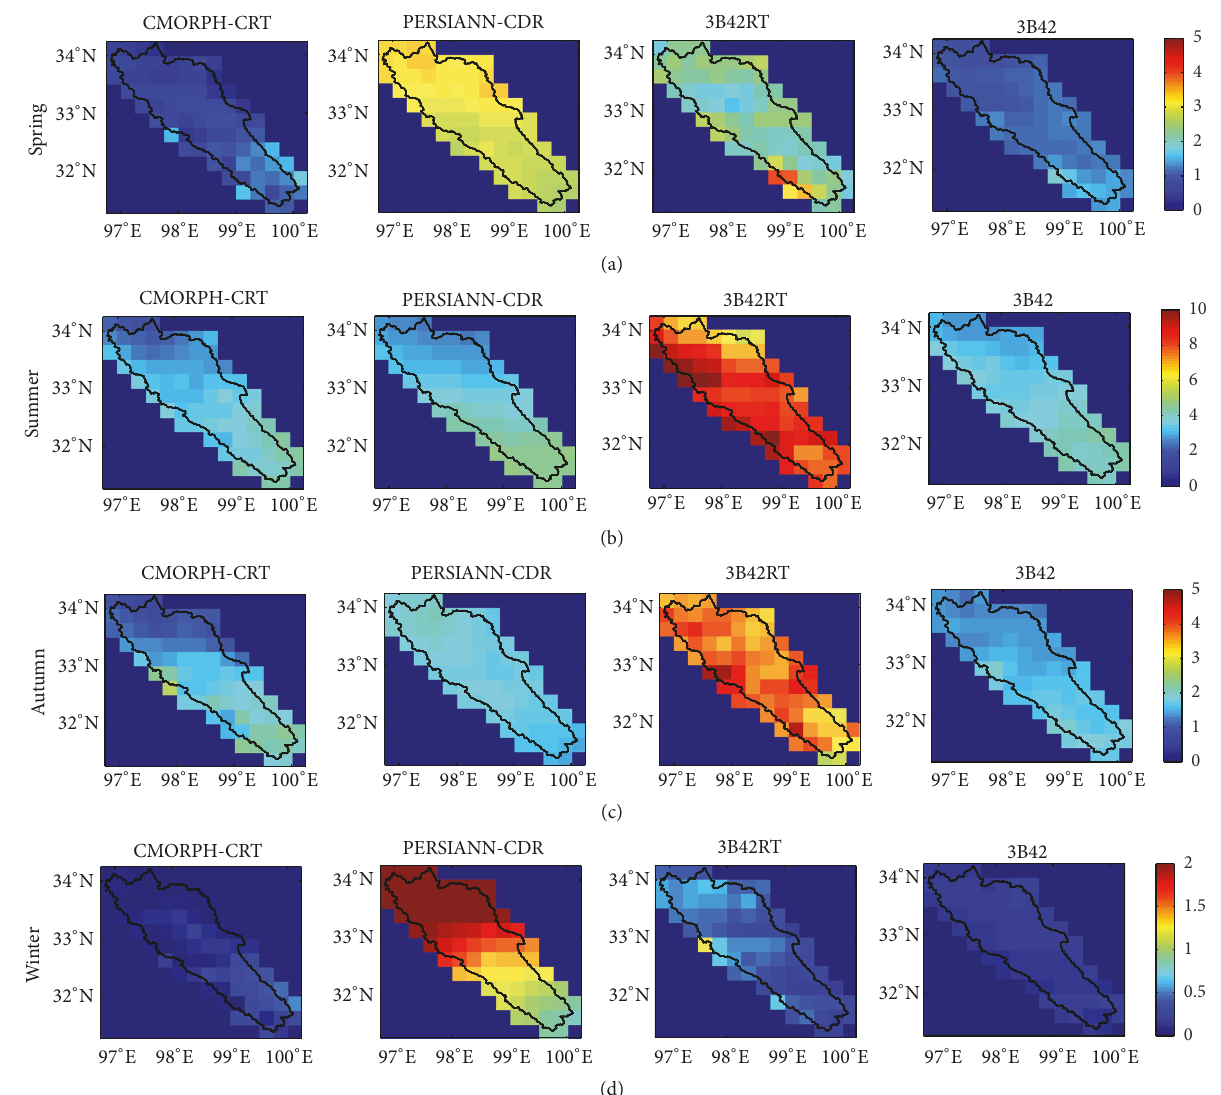
Figure 5: Maps of seasonal daily average precipitation (mmday −1 ) at 0.25 ∘ resolution derived from CMORPH-CRT, PERSIANN-CDR, 3B42RT, and 3B42 estimates for spring, summer, autumn, and winter (from (a) to (d)) over GRB during the period 2008 to